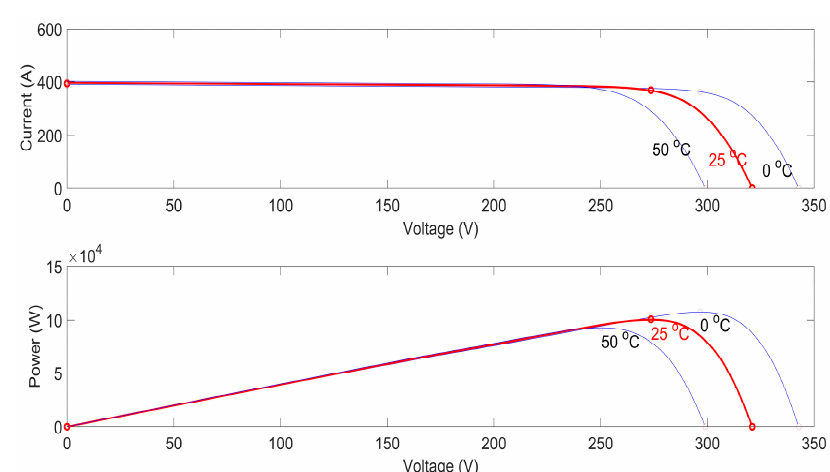
Figure 8. I-V and P-V characteristics of the solar Photovoltaic array model used in the simulation analysis.